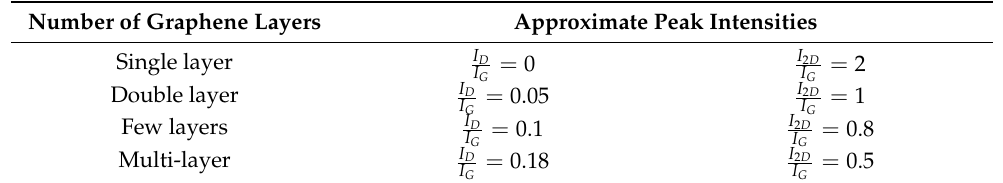
Table 3. The ratio of peak intensities and number of layers.